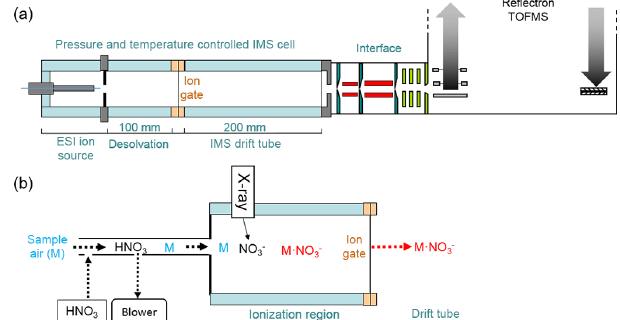
Figure 1. A schematic diagram of the IMS–TOF (a) . The instru- ment can be used with different ionization sources, including the ESI source shown in (a) and the custom-built nitrate-ion chemical ionization source (NO − -CI) attached to the front end of the desol- 3 vation region shown in (b) . The diagram is not drawn to